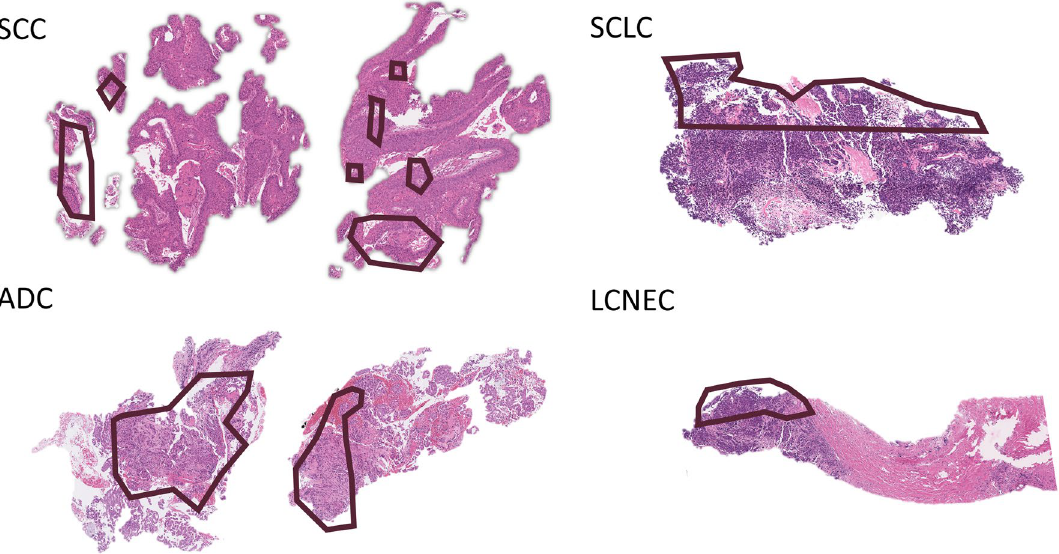
Figure 5. Top K -patches in WSI. Top-50 patches are